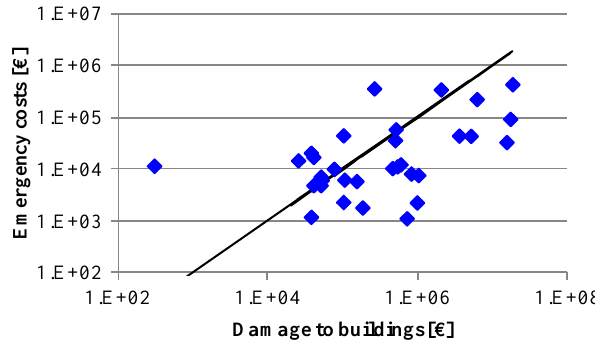
Fig. 8. Comparison among damage to buildings and emergency Figure 8. Comparison among damage to buildings and emergency costs as derived from the 2 costs as derived from the RaSDa database and from the model de- veloped by Penning-Rowsell et al. (2005) for the event of November RaSDa database and from the model developed by Penning-Rowsell et al. for the event of 3 2002 in the province of Sondrio ( r 2 = 0 . 5). Points represent field data, while the line represents the model. N.B. The log scale has November 2002 in the Province of Sondrio (r 2 =0.5). Points represent field data, while line 4 been assumed for both represents the model. N.B. The log scale has been assumed for both axes. 5